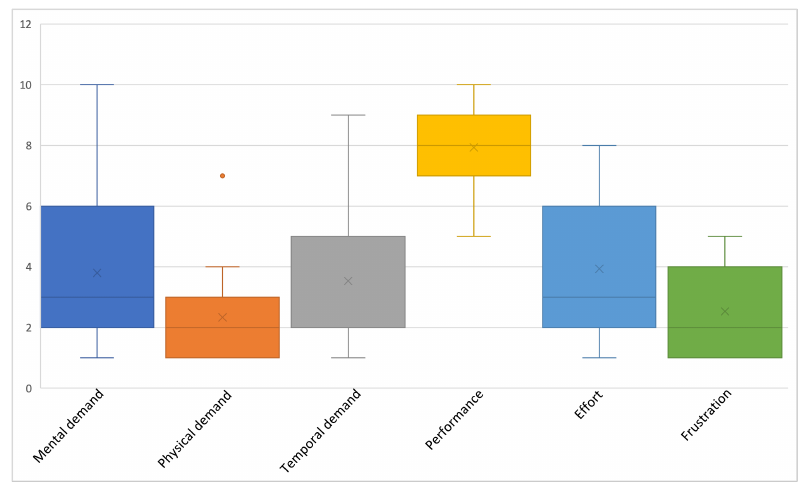
Figure 26. A boxplot of the NASA-TLX result for the analysis of biological efficacy in by-products use case. Each of the six subscales was captured with a 10-point continuous scale from very low (1) to very high (10) . The X-axis indicates the sub-dimensions of the score. The Y-axis indicates the statistics for each sub-dimension.